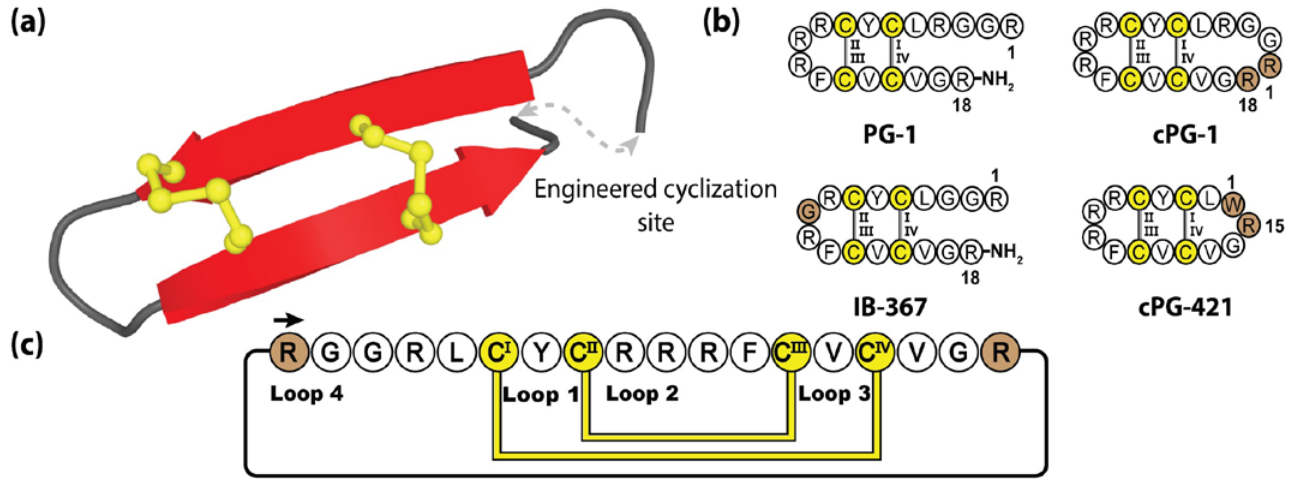
Figure 10. ( a ) Three-dimensional structure of the prototypical protegrin PG-1, with engineering cyclization site. ( b ) The native peptide sequence of PG-1 and three engineered protegrins variants [163,167]. ( c ) Depiction of the amino acid sequence and disulfide bond connectivity of the cyclic protegrin cPG-1. Cysteine residues are numbered and highlighted in yellow, with the engineered sequences and junction points represented by brown shading.